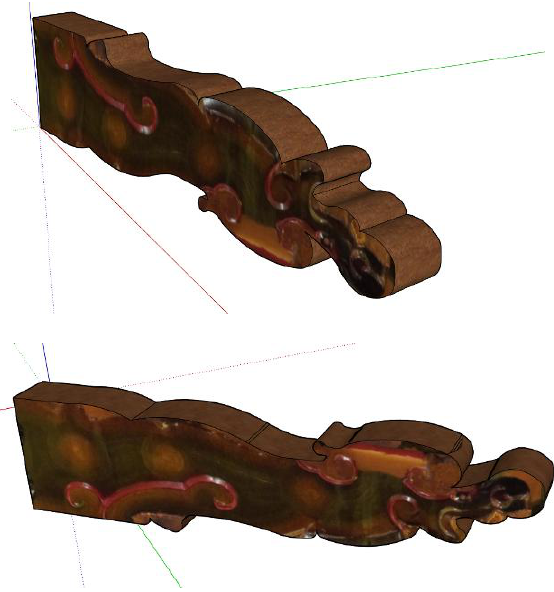
Figure 12. Component unit simulation: